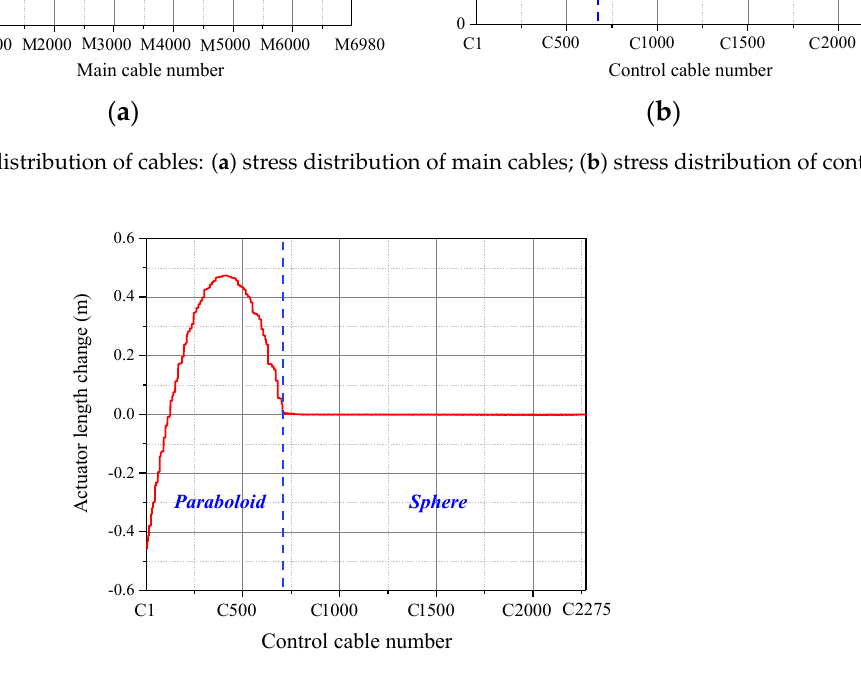
Figure 17. Actuator length changes in form deformation analysis.